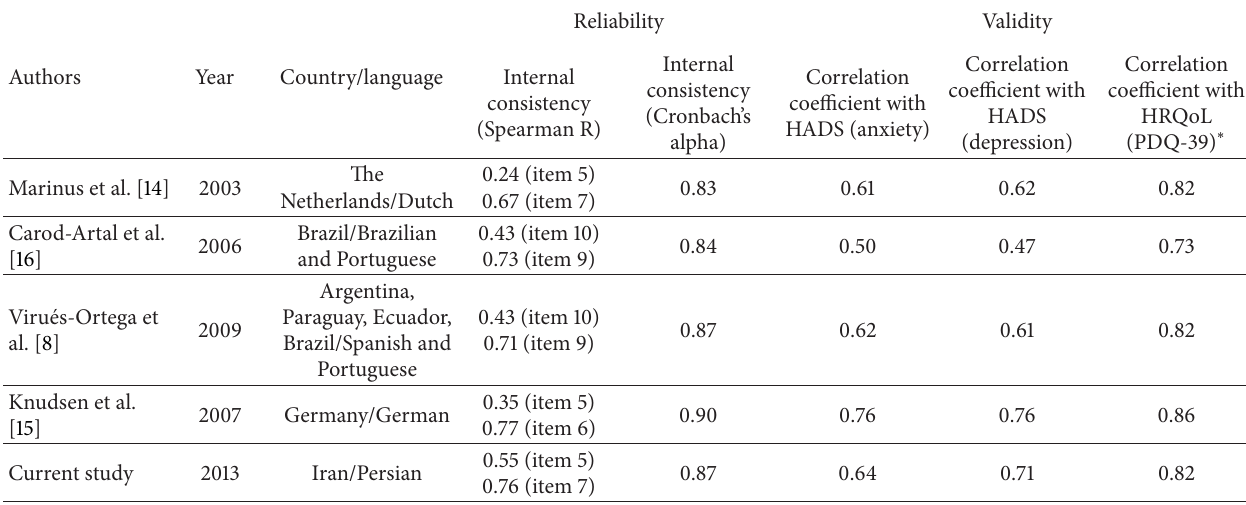
Table 5: Validity, reliability, and psychometric properties of the SCOPA-PS in different languages/cultures (two different coefficients are reported for some indices to show the lowest and highest item-specific calculated reliability). Authors Year Country/language